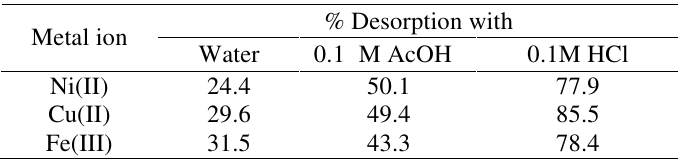
Table 5. Results of